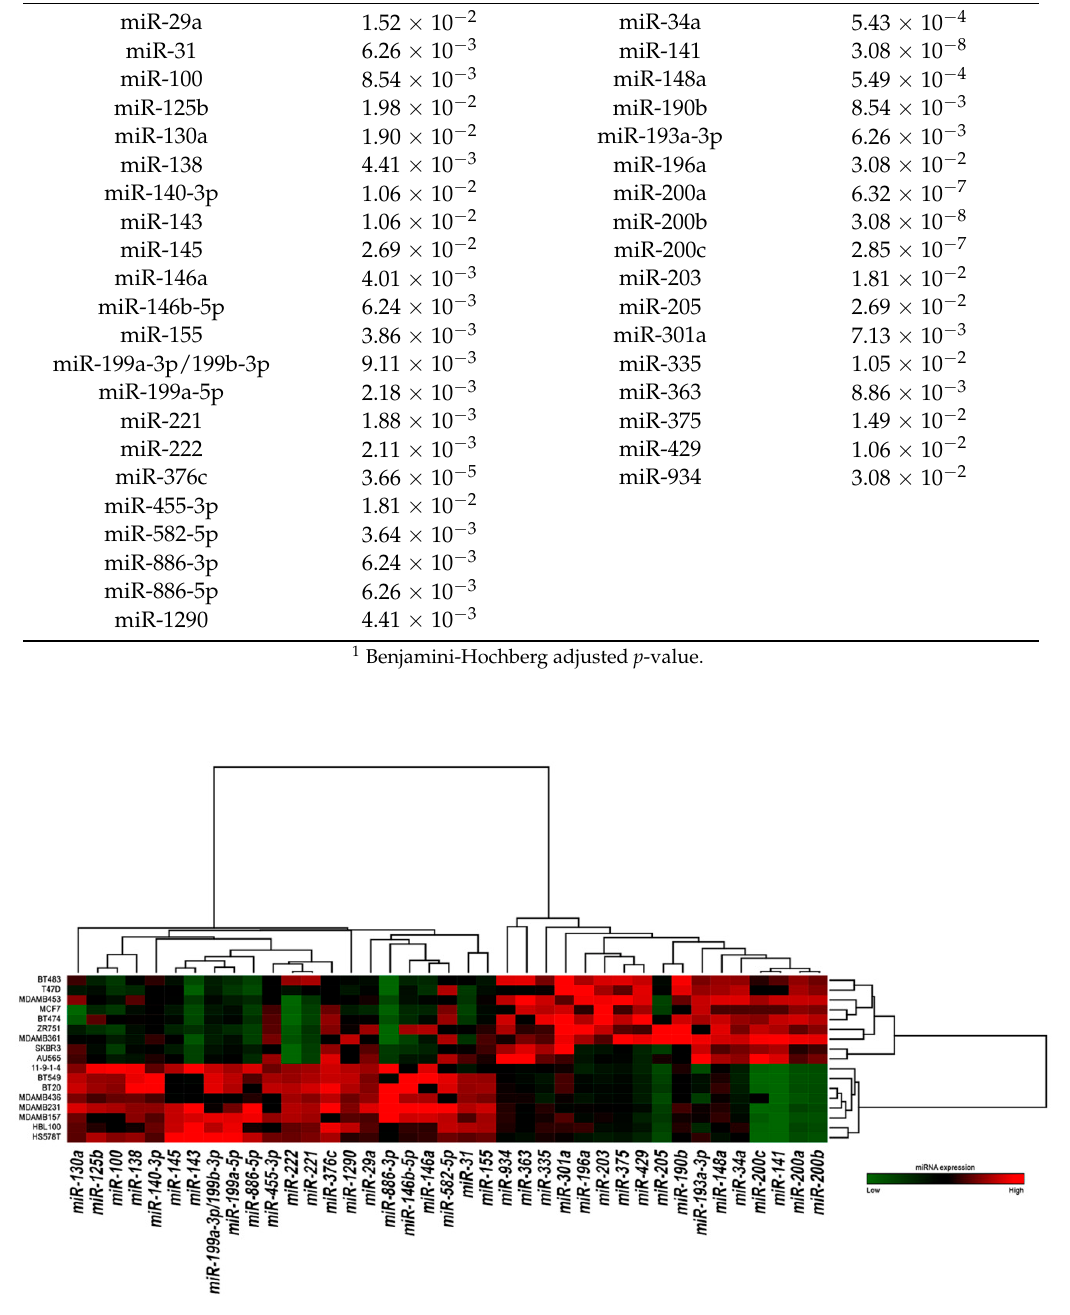
Figure 1. Hierarchical clustering of the 39 most differentially expressed miRNAs in 17 breast cancer cell lines. Expression values of miRNAs are represented in a matrix format, with columns indicating miRNAs and rows indicating samples. High expression values are color-coded red, and low expression values are color-coded green. Hierarchical clustering of both miRNAs (columns) and samples (rows) are shown.